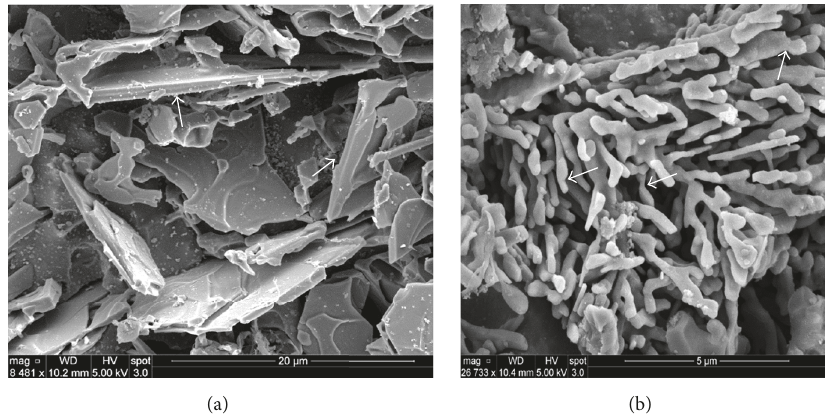
Figure 8: Eutectic Si morphology revealed in deep etched samples of (a) base alloy without Sr and (b) base alloy +